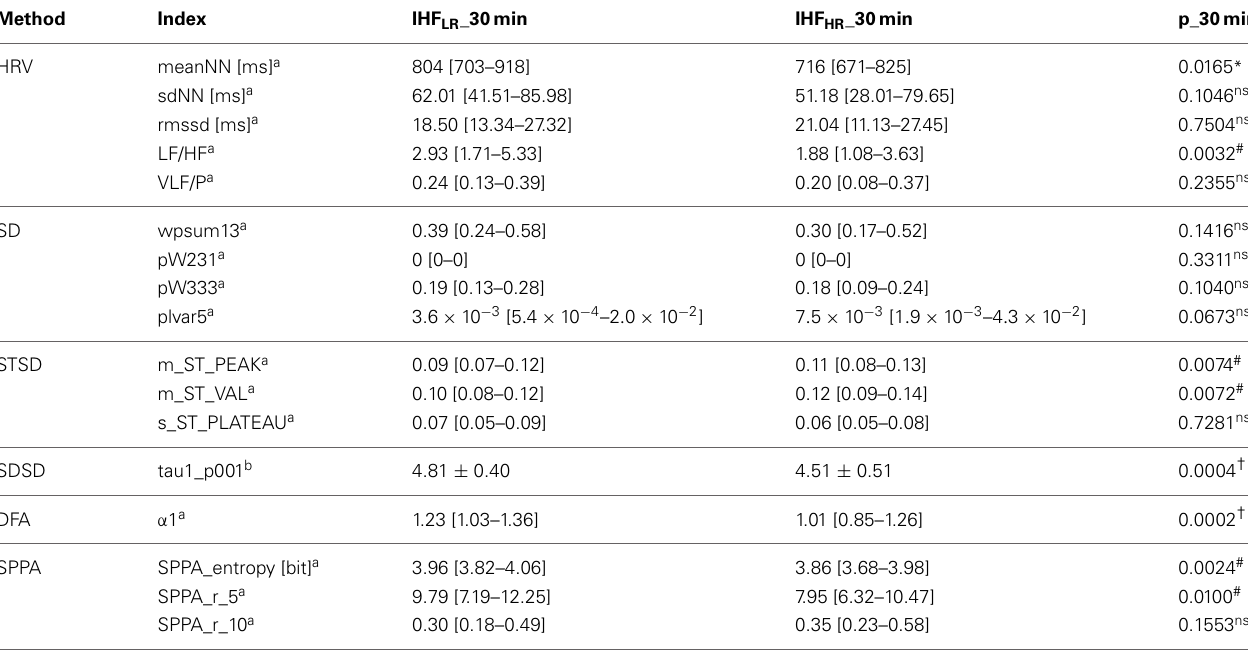
Table 3 | Analysis of first 30min ECG segments: univariate statistical analysis results ( U -test) to discriminate between patients with ischemic heart failure at low risk and at high risk (IHF LR and IHF HR ).